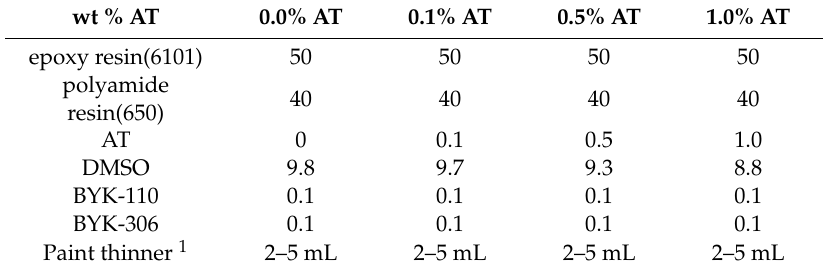
Table 1. Formulation of the epoxy coating with aniline tetramer as corrosion